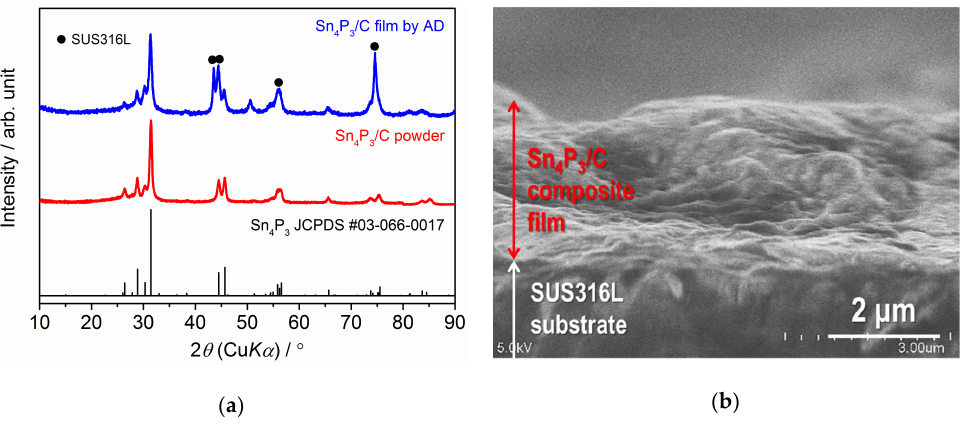
Figure 3. ( a ) SEM image of Sn 4 P 3 /C composite powder and corresponding element mapping for Sn, P and C are shown in ( b ), ( c ) and ( d ).